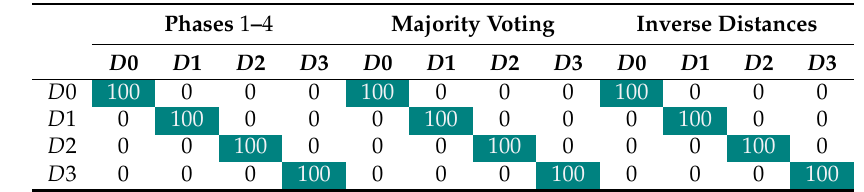
Table 4. Confusion matrix of the application of the t -SNE based damage detection and classification procedure presented in Sections 3 and 4 to the case of the aluminum plate in Scenario 2 , when the four actuation phases are used at the same time, in the frequency domain . Rows represent true values, while columns represent predicted values.